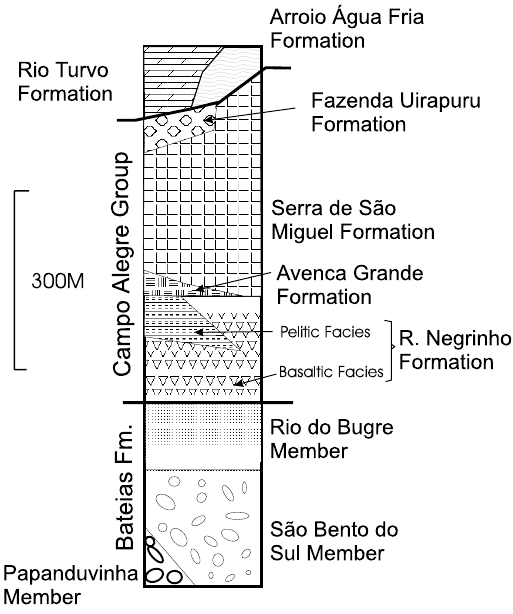
Fig. 7 – Stratigraphic column of the Campo Alegre Basin pro- posed: Bateias Formation- Members Papanduvinha (fanglom- erates), São Bento do Sul (conglomerates) and Rio do Bugre (sandstone and siltstones); Campo Alegre Group: Rio Negrinho Formation- volcanic facies (basalts and andesites), pelitic facies (laminated siltstones); Avenca Grande Formation (ignimbrites), Serra de São Miguel Formation (trachytes and quartz trachytes), Fazenda Uirapuru Formation (volcaniclastic breccia); Rio Turvo Formation (pelites, tuffs and ignimbrites);ArroioAgua Fria For- mation (rhyolites and